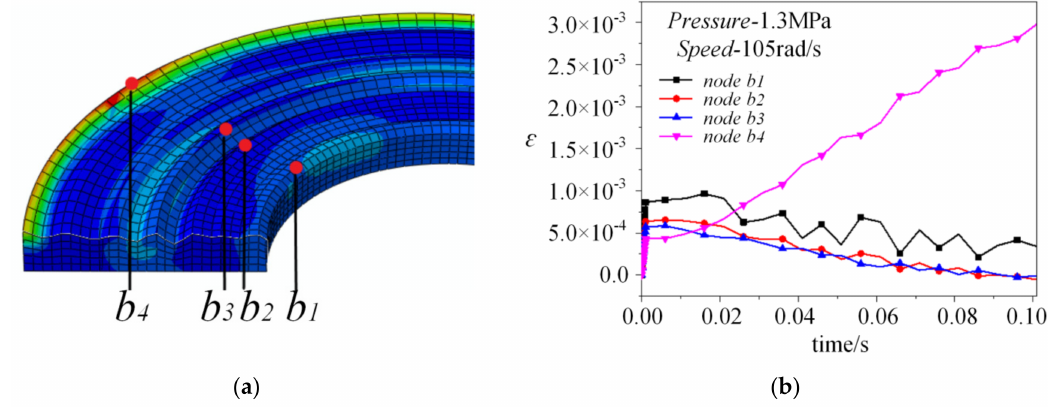
Figure 9. Strain analysis for the upper part. ( a ) Reference nodes for strain analysis. ( b ) Strain curve of the